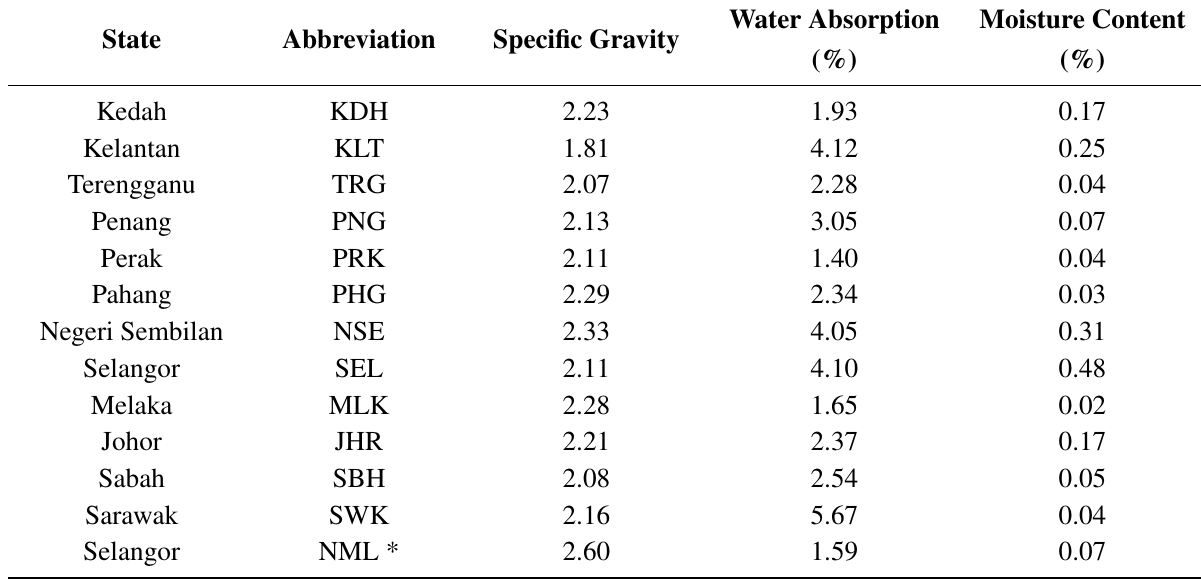
Figure 5. Particle size distribution for ordinary Portland cement (CEM I) 52.5N. Table 4. Physical characteristics of the aggregate.